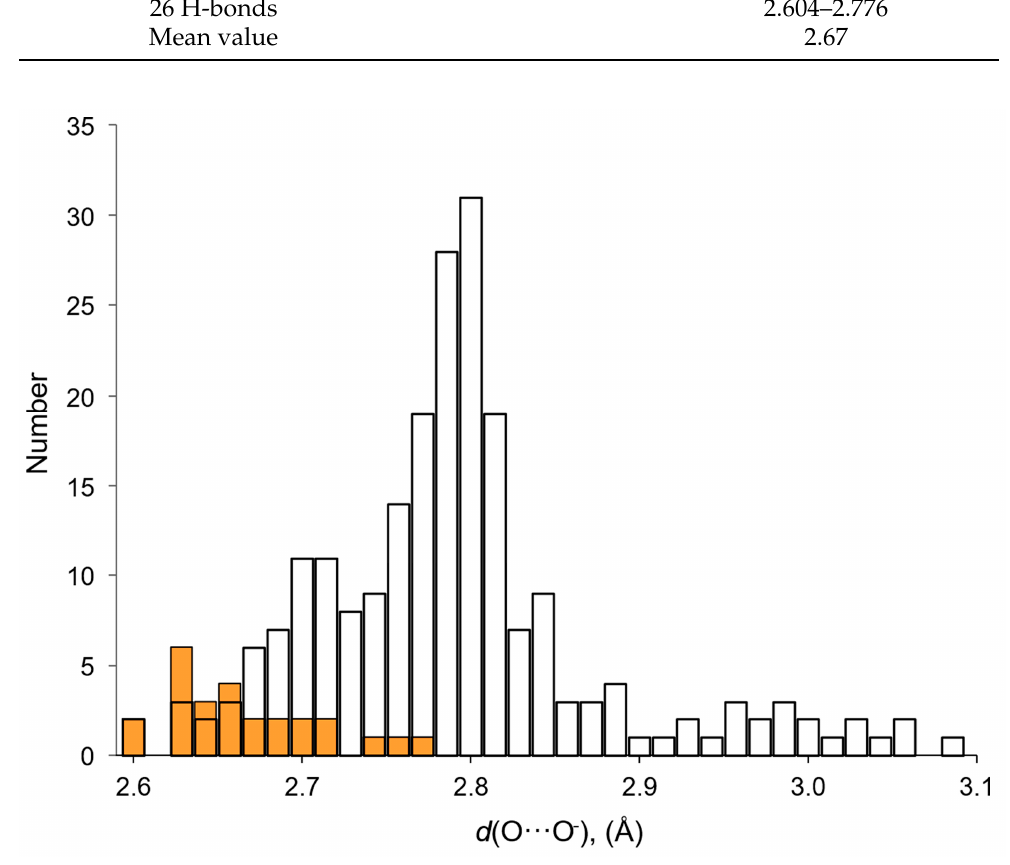
Figure 8. Distribution of O ··· O − distances d (O ··· O − ) in H-bonds formed by hydrogen peroxide and water molecules as proton donors in amino acid crystals. White bars—crystalline hydrates; orange bars—peroxosolvates.